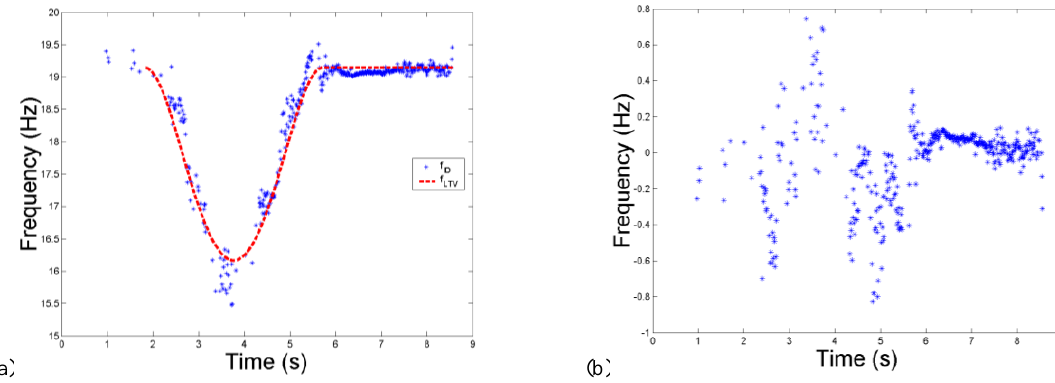
Fig. 8. First natural frequency extracted by means of ST-SSI compared with the theoretical natural frequency depending only on the moving mass (a) and difference between the two curves (b). In Fig. 8a, the identified frequency is depicted, together with the theoretical one, depending only on the moving load, while in Fig. 8b the difference between the two curves is visualized. The theoretical frequency has been ob- tained by considering the modal mass as half the total mass and a constant velocity, according to Eq.